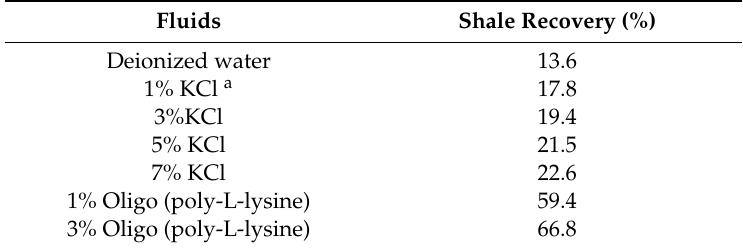
Table 5. Recovery percent of nanomaterial based drilling was found higher compared to water and KCl (di ff erent concentrations) at 393 K